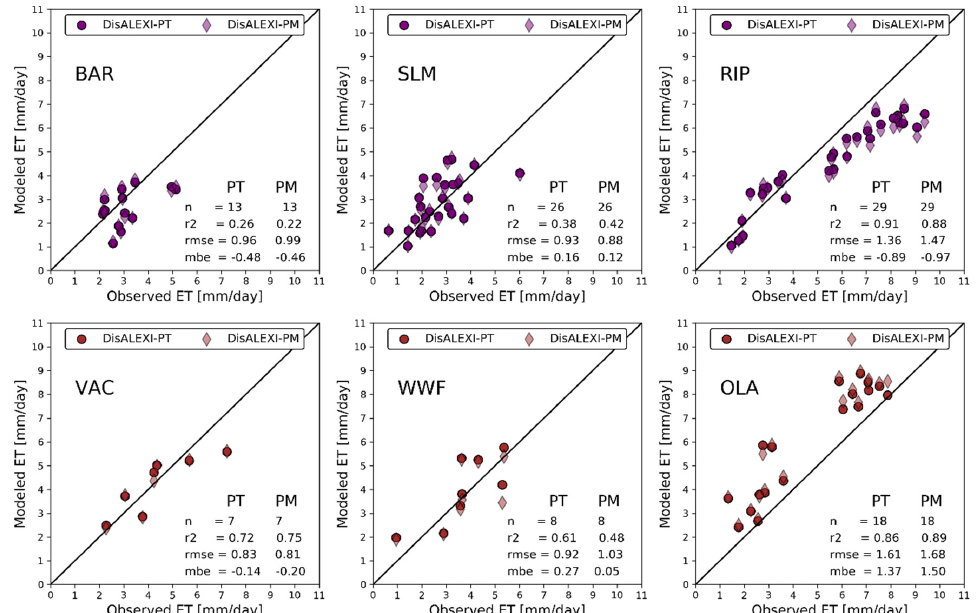
Figure 2. Scatter plots of DisALEXI-PT- and DisALEXI-PM-derived daily ET vs. observed daily ET (closed via [7]) for GRAPEX vineyards ( top ) and T-REX almond orchards ( bottom ) on clear Landsat 8 overpass dates during 2021. Additionally included are statistical measures n (number of clear-sky images available), r2 (coefficient of determination), rmse (root mean square error), and mbe (mean bias error). Differences between the number of comparison points (n) and the number of clear-sky days (Table 1) are due to missing observed data during the Landsat overpass.